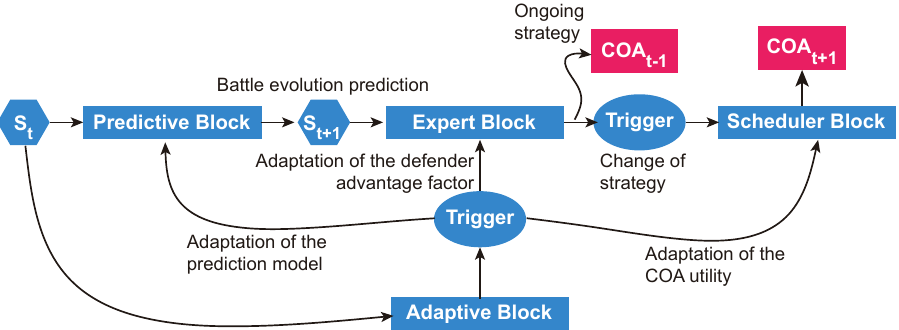
Figure 2. Primary elements that trigger the choice of a specific COA in the new framework through a sequential